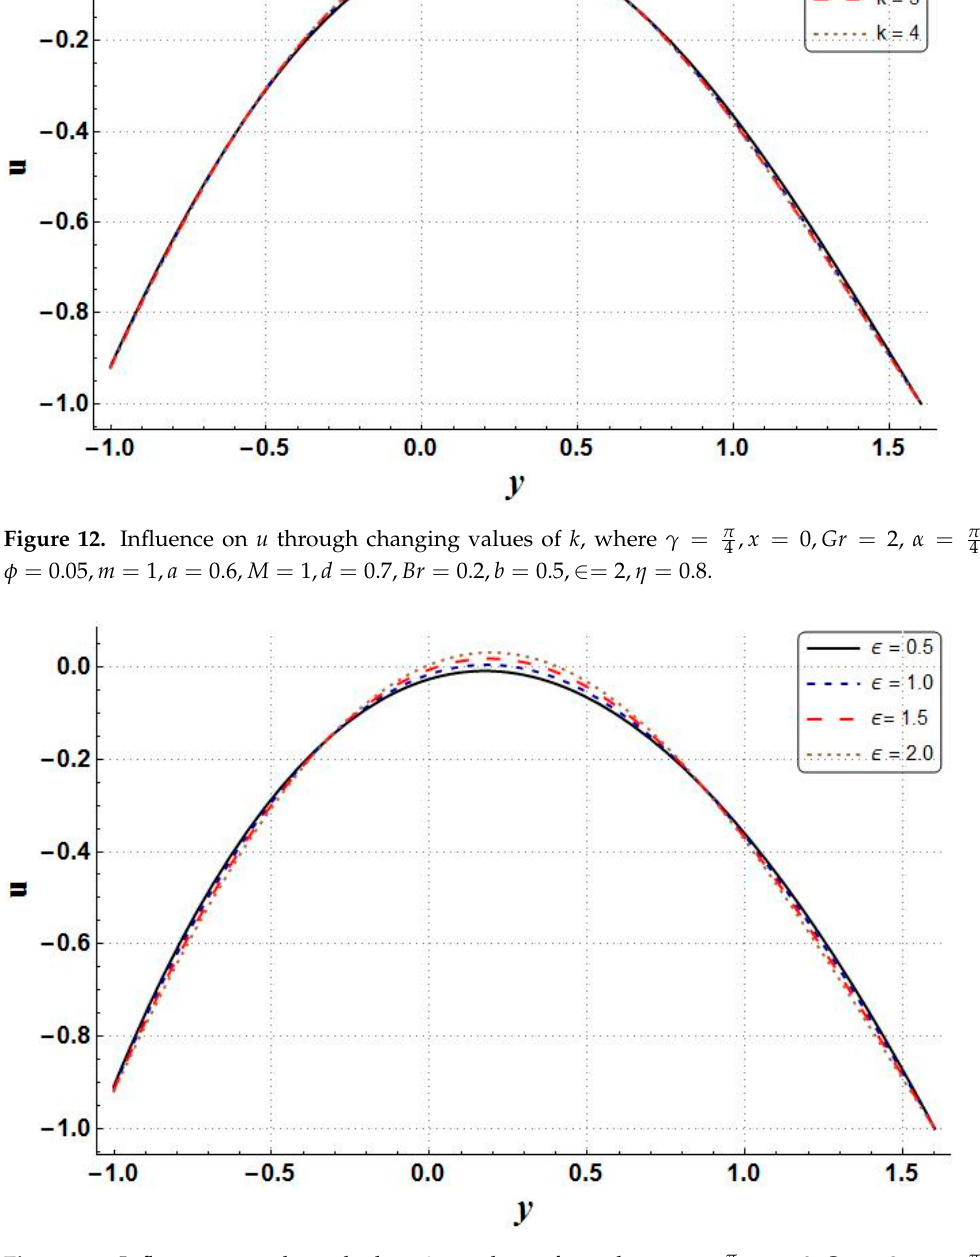
, x = 0, Gr = 2, α = π 4 ∈ , where